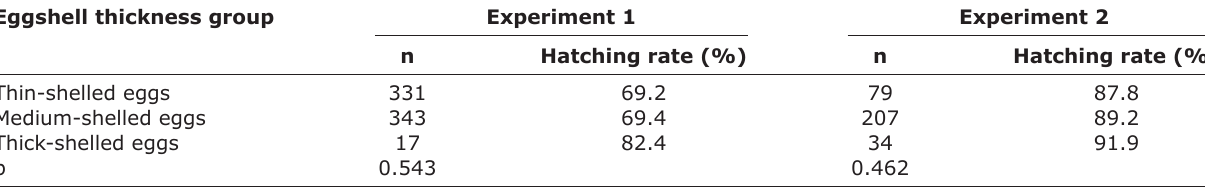
Table-2: Hatching rates of eggshell thickness groups in two different experiments. Eggshell thickness